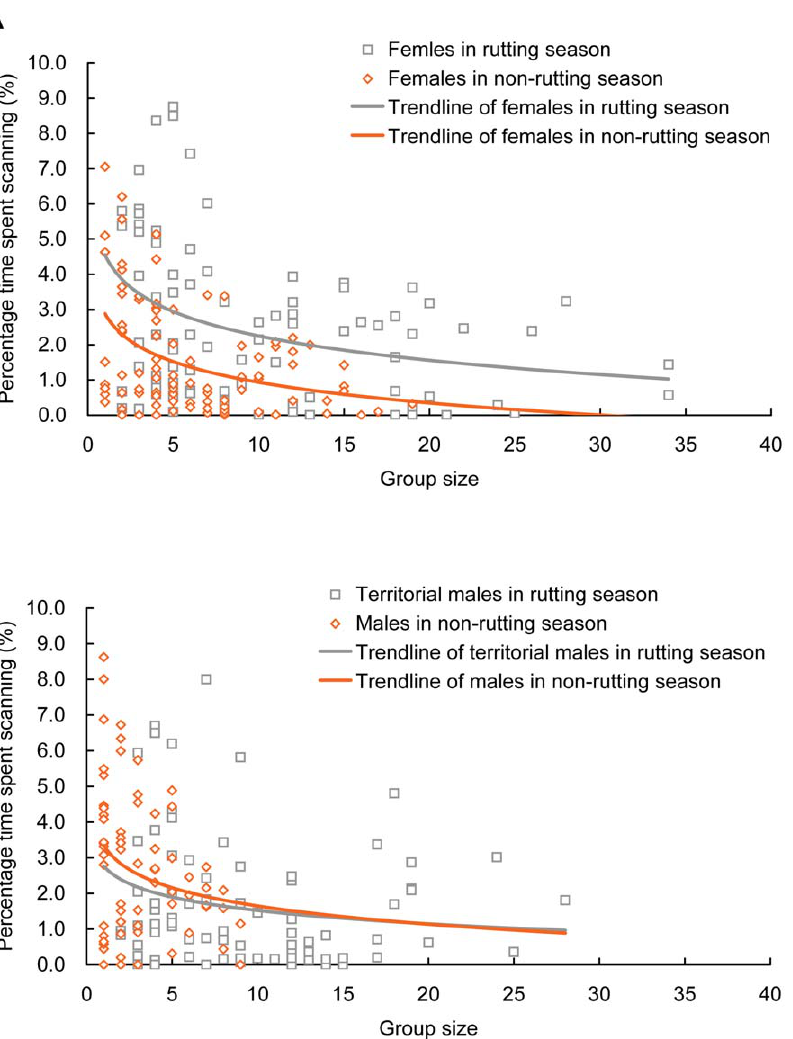
Figure 1. Relationship between percentage time spent scanning and group size in female A) and male B) Przewalski’s gazelle. Non- territorial males in rutting season often grazed alone. Thus, the relationship between percentage time spent vigilant, which averaged 7.0% 6 0.9% and peaked at 33.4%, and group size in non-territorial males is not displayed.